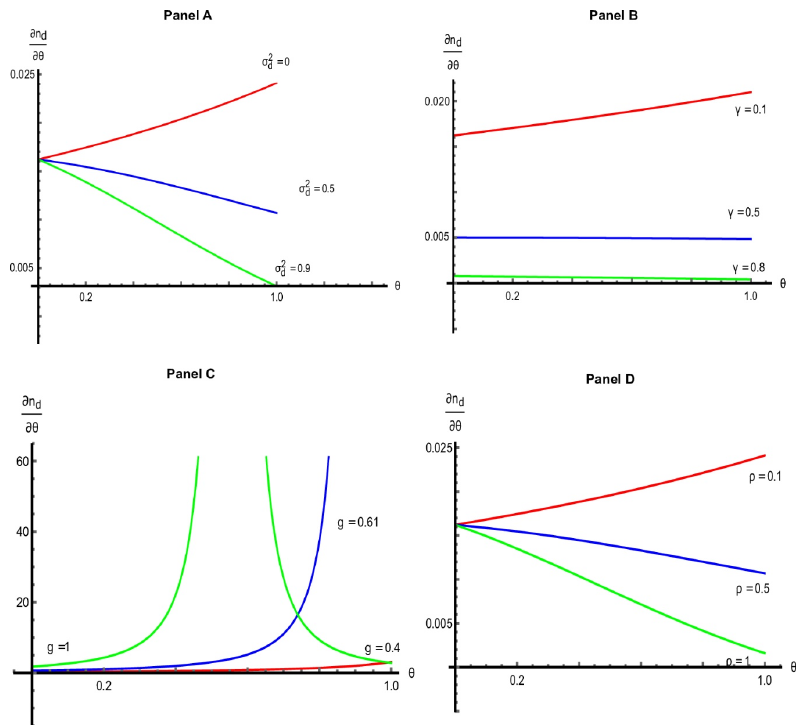
Figure 1. Impact of the indirect network effect affecting viewers on the equilibrium number of online gamers for a given change in parameters 𝜎 (cid:3031)(cid:2870) , 𝛾 , 𝑔, and 𝜌 . Panel A simulates the variation of 𝜕𝑛 (cid:3031)∗ /𝜕𝜃 for different values taken by parameter 𝜎 (cid:3031)(cid:2870) . Panel B simulates the variation of 𝜕𝑛 (cid:3031)∗ /𝜕𝜃 for different values taken by parameter 𝛾 . Panel C simulates the variation of 𝜕𝑛 (cid:3031)∗ /𝜕𝜃 for different values taken by parameter 𝑔 . Panel D simulates the variation of 𝜕𝑛 (cid:3031)∗ /𝜕𝜃 for different values taken by parameter 𝜌 .